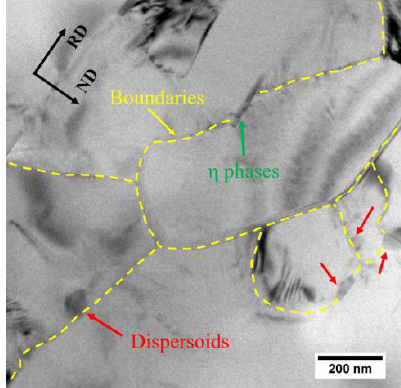
Figure 14. The TEM observation of the pinning effect of particles on boundaries in the FH sample quenched at 300 °C.